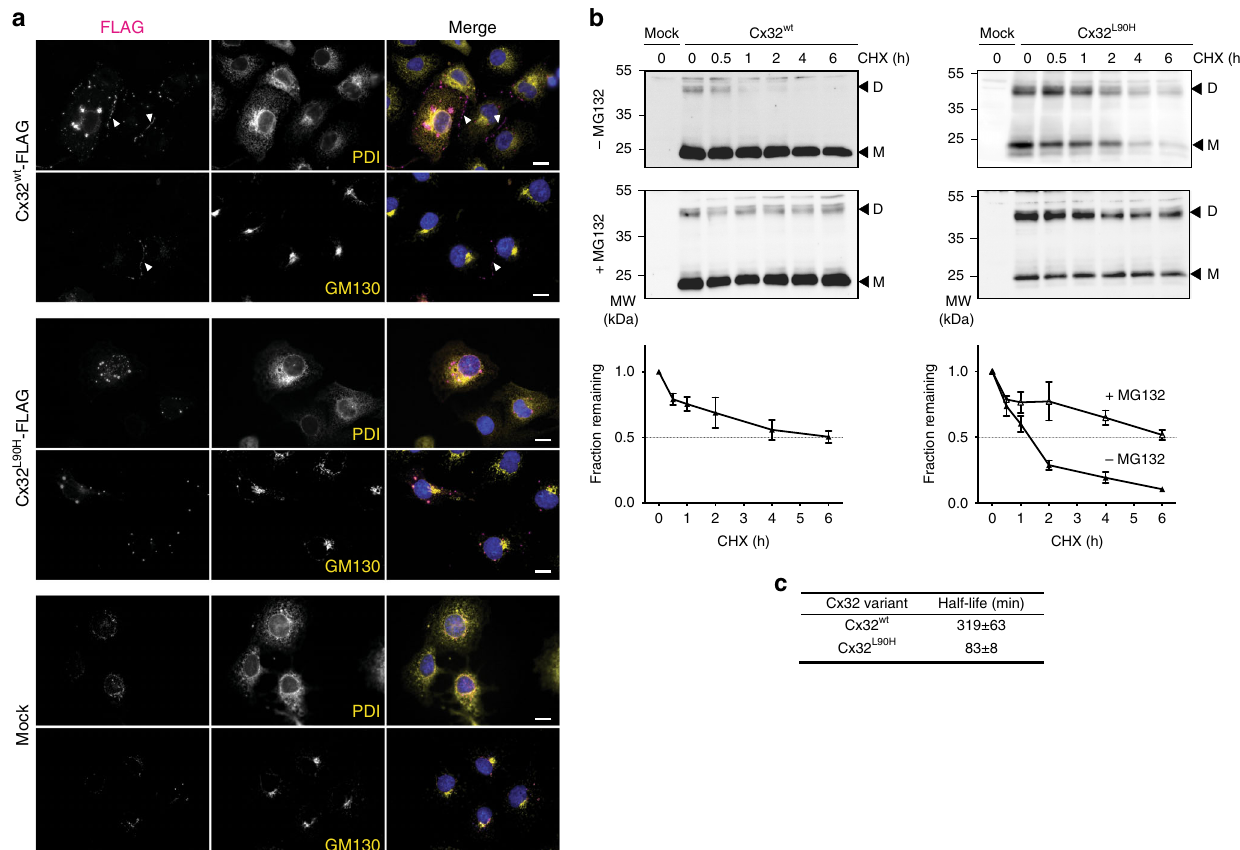
Fig. 2 Cx32 L90H shows defects in gap-junction formation and rapid degradation. a COS-7 cells were transfected with the indicated constructs and immunostained for FLAG-tagged Cx32 (magenta), PDI (yellow) as an ER marker, or GM130 (yellow) as a Golgi marker. Nuclei were stained with DAPI (blue). Anti-FLAG immuno fl uorescence data are depicted as maximum intensity projections from deconvoluted z-stacks, while PDI, GM130, and nuclei are shown as a central cell plane from the same, nondeconvoluted images. Gap-junction plates lining cell – cell boundaries are indicated with white arrowheads. Pictures are representative of cells from at least three different biological replicates. Scale bars correspond to 20 µ m. b HEK293T cells transfected with the indicated constructs were incubated with either cycloheximide (CHX) alone, or additionally with the proteasome inhibitor MG132 where indicated. Arrowheads indicate monomer (M) and dimer (D) bands quanti fi ed to determine Cx32 turnover. Quanti fi cations are shown below the immunoblots (mean ± SEM, N ≥ 3). c Half-lifes without MG132 for Cx32 wt and Cx32 L90H as derived from b are